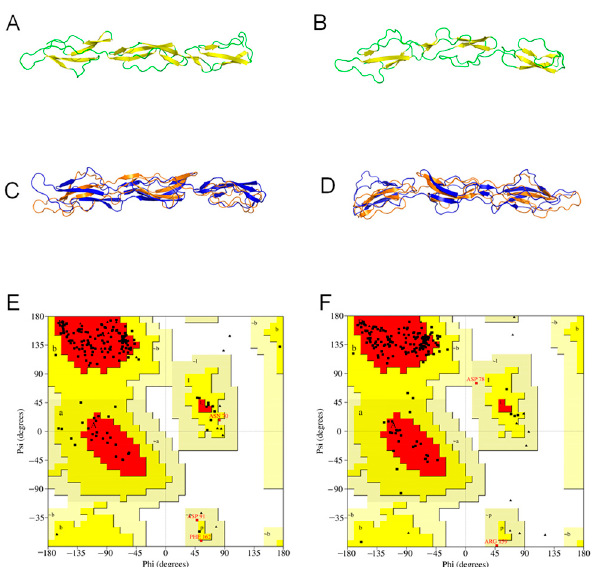
Figure 3. Protein structure optimization of CR1-like fragments. ( A , B ) CR1-like SCR 12–14 and CR1-like SCR 19–21 models after molecular dynamics simulation. The yellow region is the β -fold, and the green region is the loop region. ( C , D ) Protein conformational changes of CR1-like SCR 12–14 and CR1-like SCR 19–21 before and after molecular dynamics simulation. Orange models are the conformations before optimization, and blue models are the optimized conformations. ( E , F ) Ramachandran plots of optimized CR1-like SCR 12–14 and CR1-like SCR 19–21. Glycine residues are displayed as triangles while other residues are displayed as squares. Residues in the most favored regions (A, B, L) are those with phi and psi angles that are most energetically favorable. Residues in additional allowed regions (a, b, l, p) are less energetically favorable, but still allowed. Residues in generously allowed regions (~a, ~b, ~l, ~p) are the least energetically favorable but still possible.